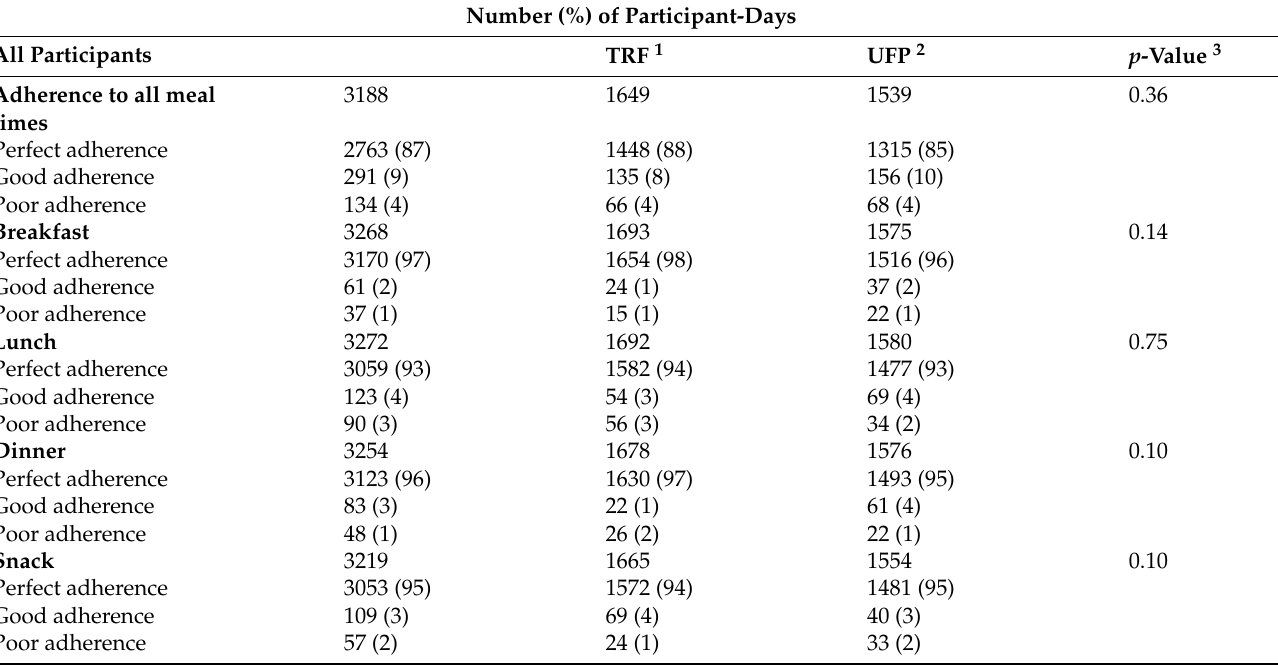
Table 2. Adherence to meal timing overall and by study arm.